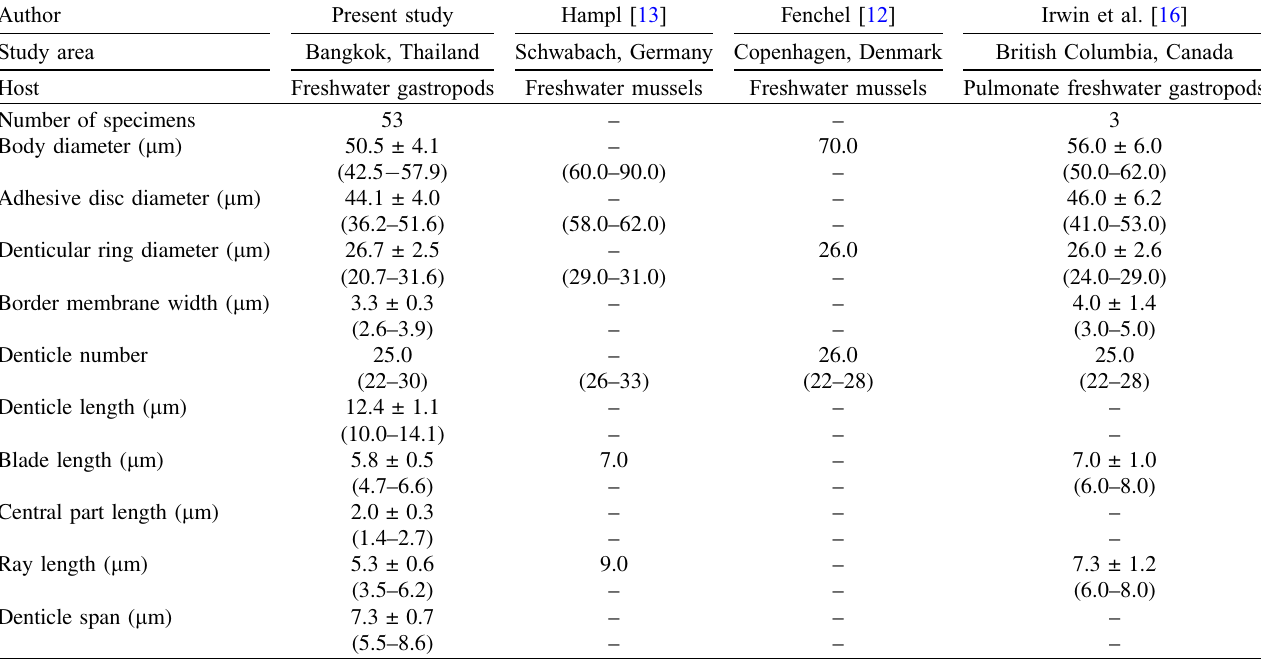
Table 3. Measured and counted characters of Trichodina unionis between the present study and previous